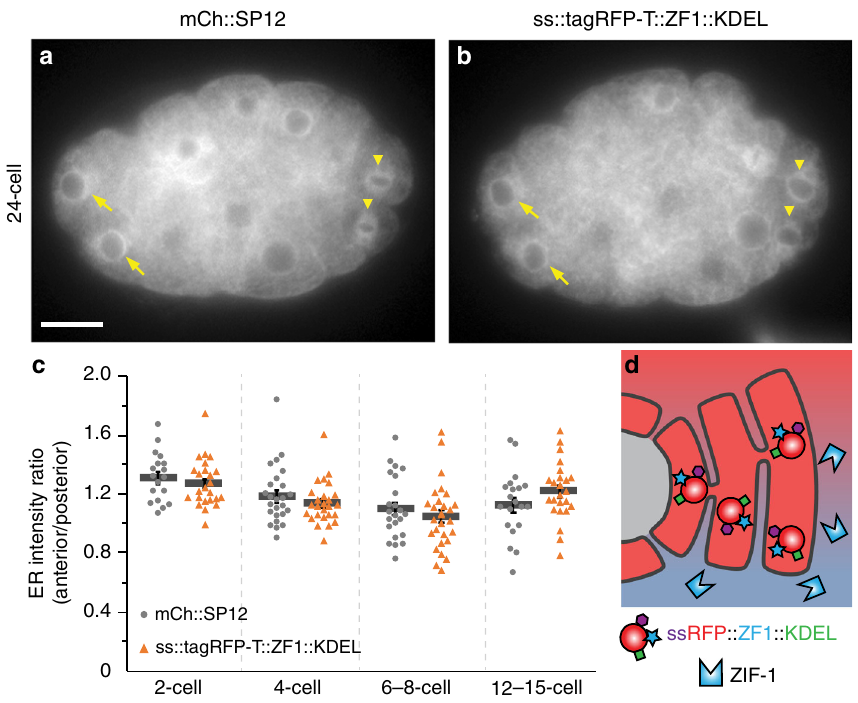
Fig. 10 A ZF1 degron reporter in the ER is protected from ZIF-1/ECS-mediated degradation. a mCherry-tagged SP12 localizes to the endoplasmic reticulum (ER) in anterior (somatic, arrow) and posterior (germ line, arrowhead) cells ( n = 102). Scale bar: 10 µ m. b An RFP- and ZF1 degron-tagged KDEL reporter similarly localizes to the ER in both anterior (somatic, arrow) and posterior (germ line, arrowhead) cells, despite expression of the ZIF-1 ligase adaptor in anterior cells ( n = 88). c There was no signi fi cant difference in the ratio between the fl uorescence of anterior AB lineage cells and of posterior germ line or germ line sister cells at the indicated stages ( p > 0.05, Student ’ s t -test with Bonferroni correction, n = 18 – 25 mCh::SP12, n = 24 – 28 ss::tagRFP-T::ZF1:: KDEL). Bars represent mean ± s.e.m. Source data are provided as a Source Data fi le. d The ER membrane protects luminal proteins from ubiquitination